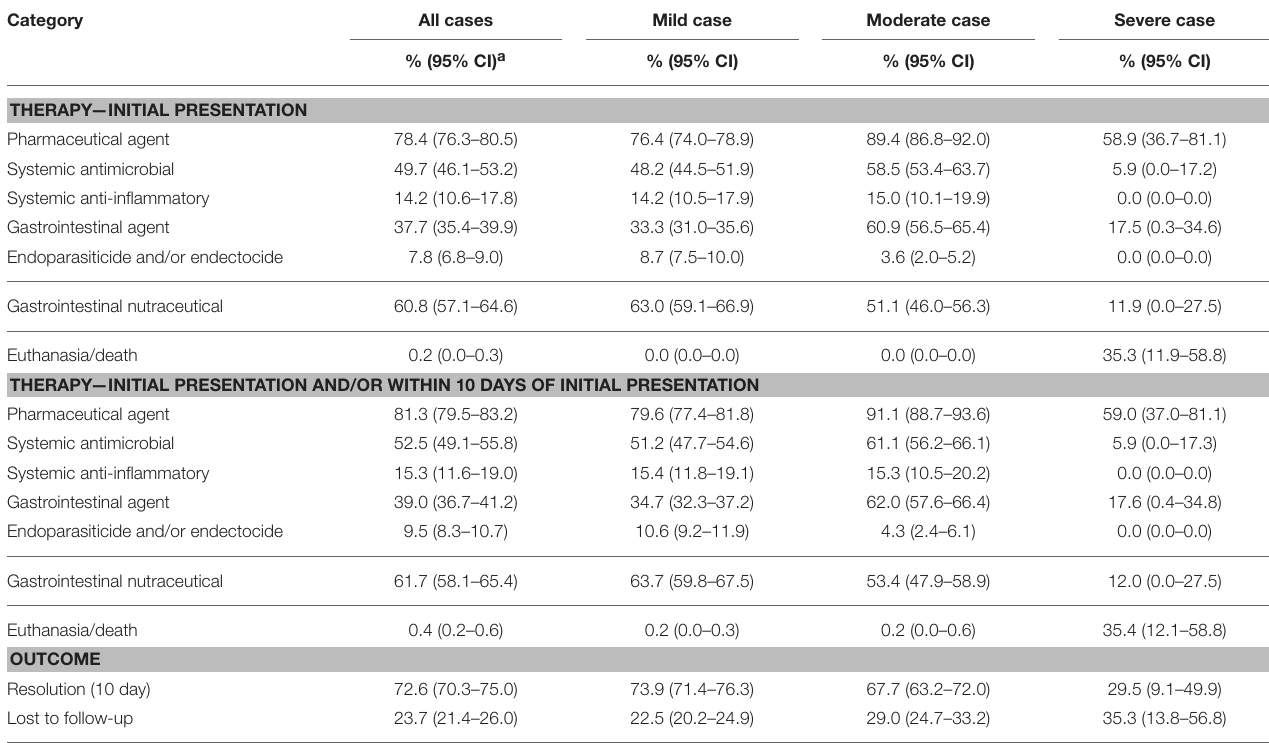
TABLE 3 | Descriptive summary of pharmaceutical prescriptions and dispensing of nutraceutical products both at initial presentation and when the subsequent 9 days (inclusive) post-presentation were considered. Category